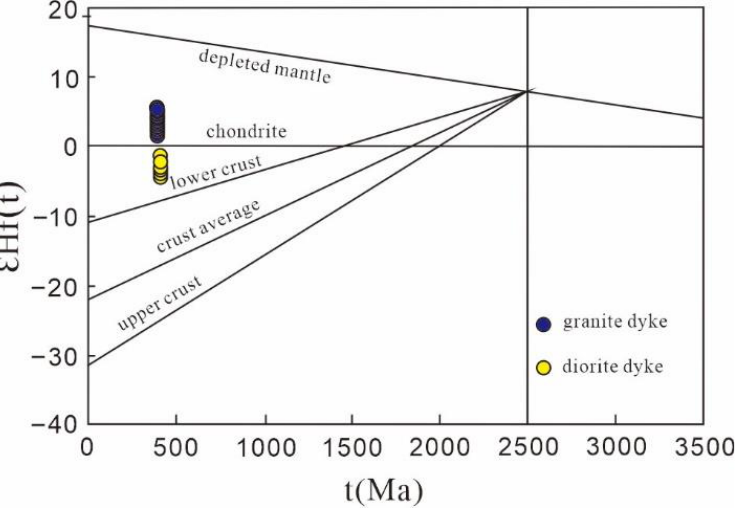
Figure 6. ε Hf(t) − t plot of granite and diorite dykes from the Jinba gold deposit. (Base map after Guo et al. [39]).